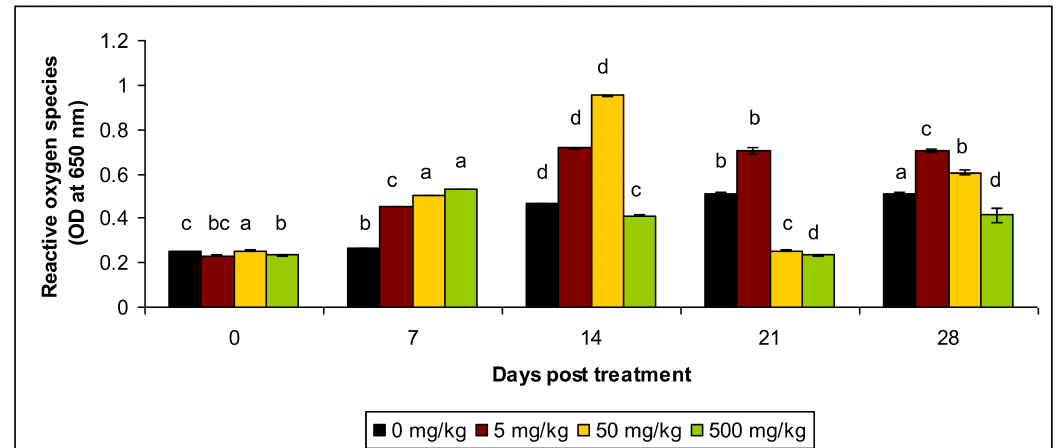
Figure 6. Effect of C. aerea extract on the reactive oxygen species production by peripheral blood leukocytes in L. rohita (values are mean ± SE). Mean values with different superscript within a column for a parameter are significantly different ( p < 0.05).